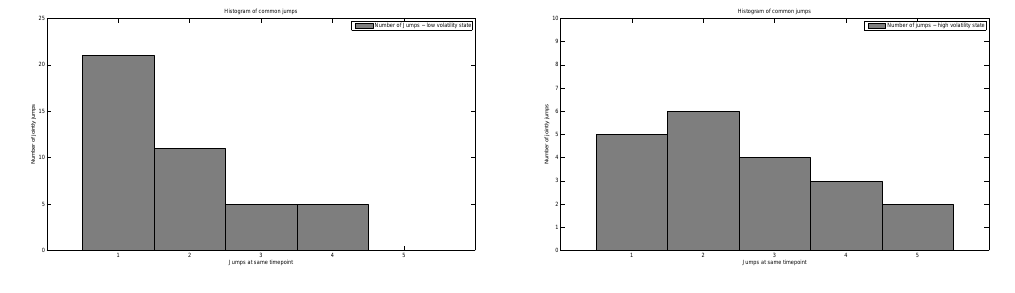
Figure 7. Histogram of the number of jumps occurring in a five-day